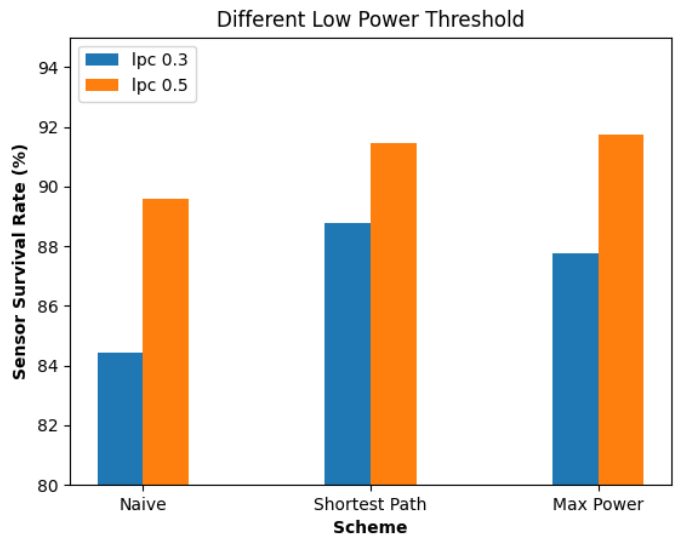
Figure 6. Impact of different 𝑙𝑝𝑐 values on the survival rate of sensors.